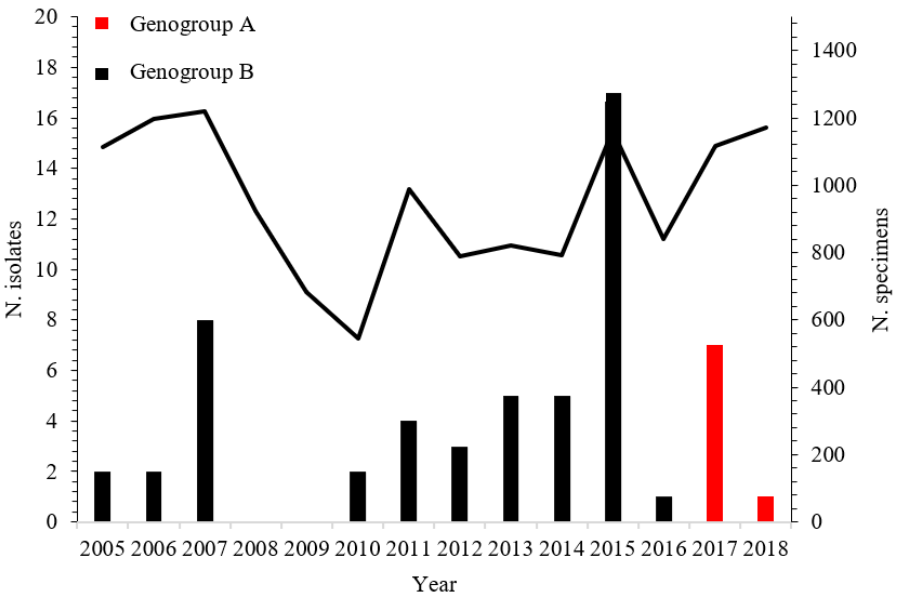
Figure 2. CVB5 distribution among AFP and aseptic meningitis cases in Brazil, 2005–2018. Surveil- lance data for AFP and aseptic meningitis (black line) and distribution of CVB5 genogroups strains (histogram bars) over time.